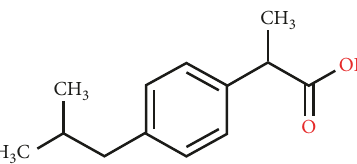
Figure 1: 2D structure of the IBU molecule by ChemDraw ® ultra 12.0